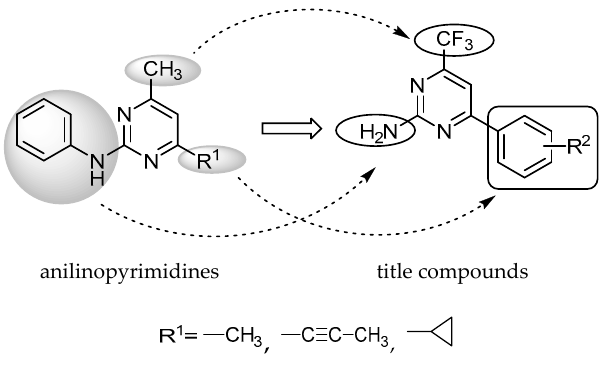
Figure 2. Design strategy for the title compounds.